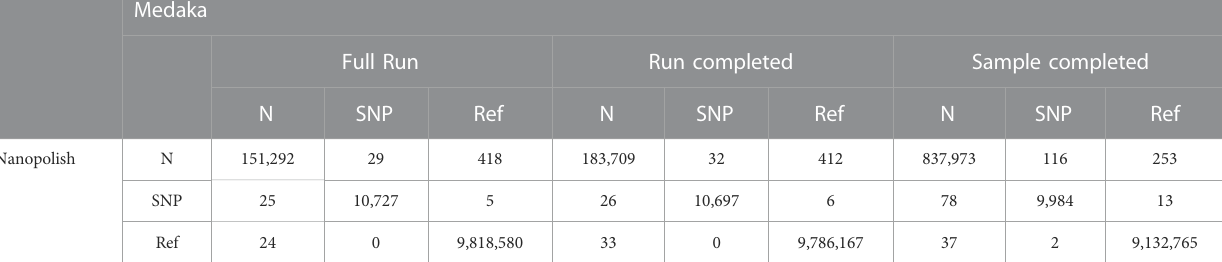
TABLE 1 Contingency table comparing SNP calling between Medaka and Nanopolish for all three time points. Displayed are total counts across all sites called as eitherreference(Ref),SNPorunknown(N).Onlygenomes presentineachcategory(FullRun,RunCompleted andSample Completed)areincluded intheanalysis. Medaka